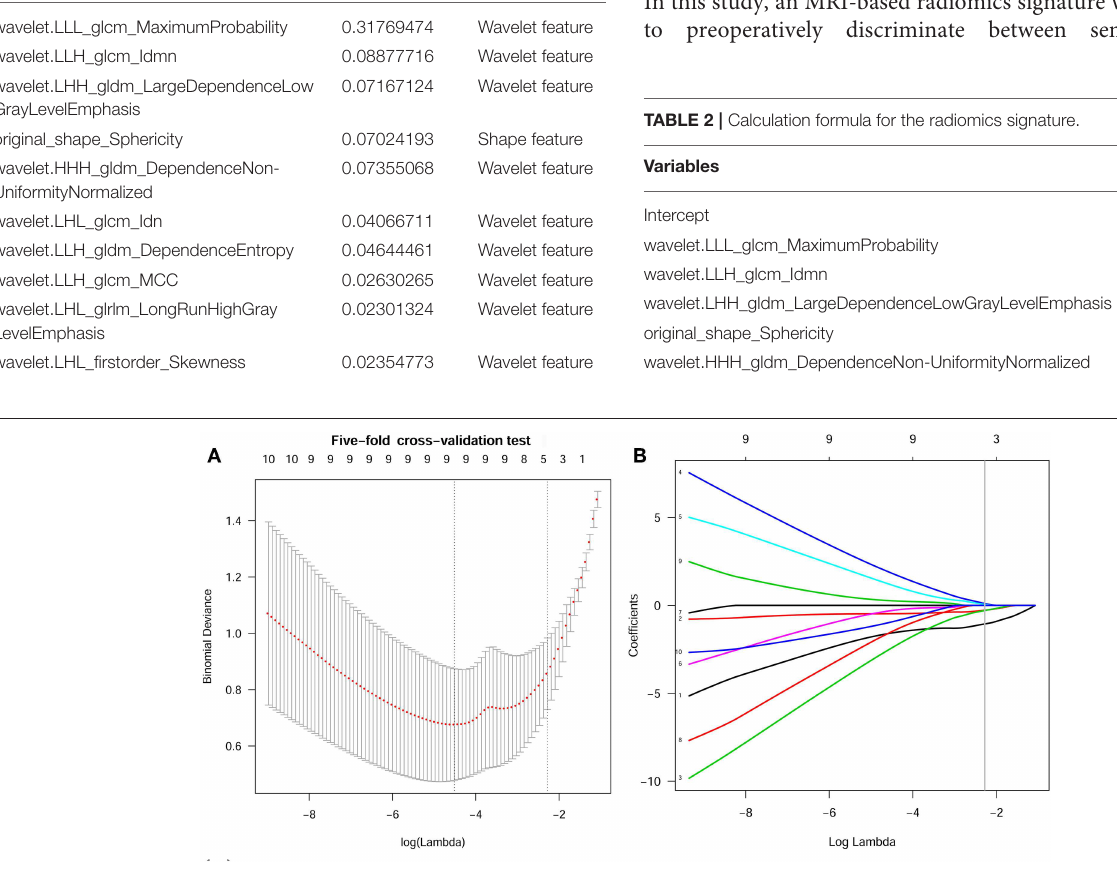
FIGURE 4 | Features selection using the LASSO algorithm. (A) Selection of the tuning parameter (Lambda) in the LASSO model using 5-fold cross-validation. Binomial deviances from the LASSO regression cross-validation model were plotted as a function of log(Lambda). The dotted vertical line at the right was drawn at the optimal value based on the minimum criteria and the 1-standard error rule (the 1-SE criteria). An optimal Lambda value of 0.102 with log(Lambda) = − 2.280 and 5 non-zero coefficients were selected. (B) LASSO coefficient profiles of the 10 texture features. A vertical line was drawn at the optimal value selected using the 5-fold cross-validation process in (A) . The 5 features with non-zero coefficients were included to construct the radiomics signature.